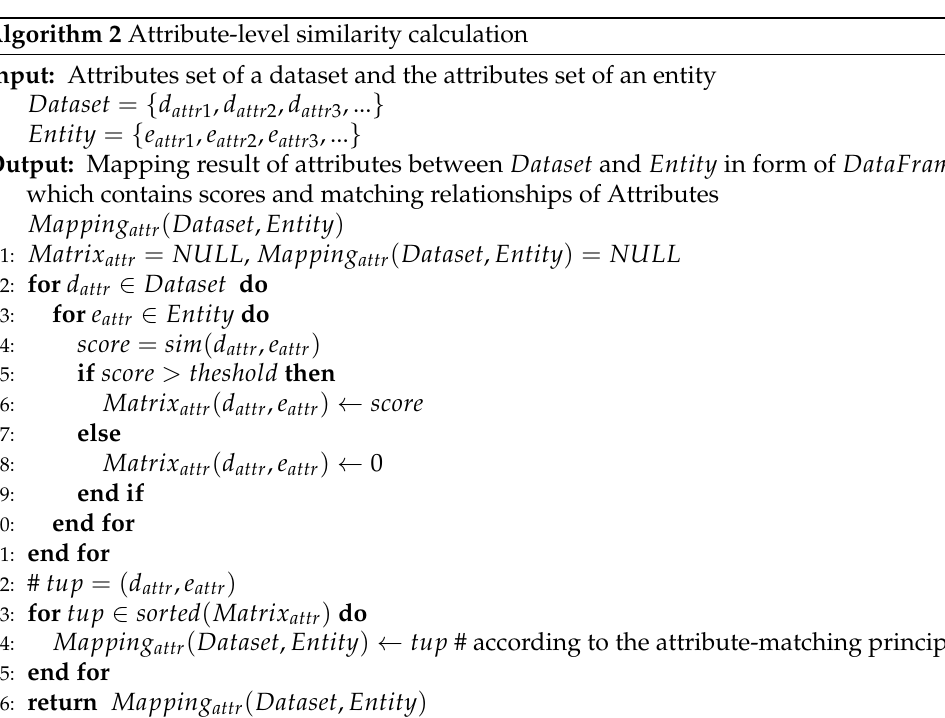
Algorithm 2 Attribute-level similarity